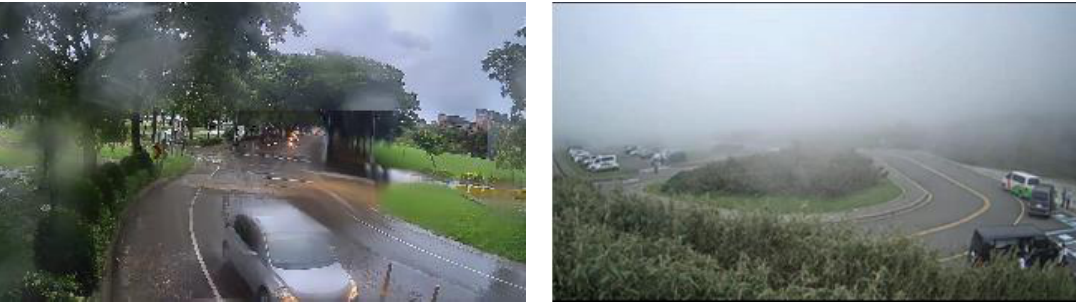
Figure 1. Extreme weather conditions.